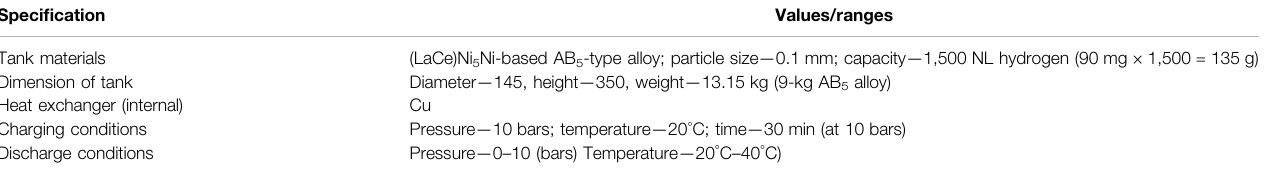
TABLE 2 | Technical speci fi cations of the MH